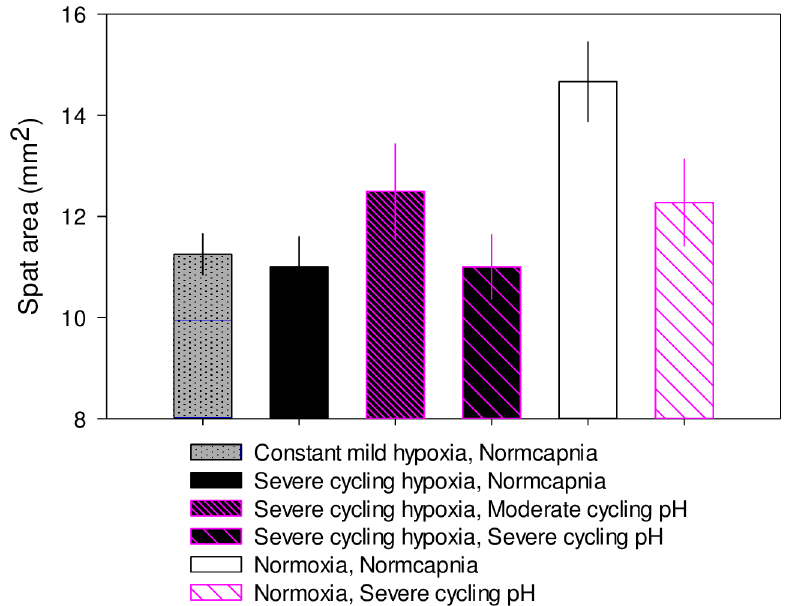
Fig 4. 2014 juvenile growth experiment. Mean ± 1 SE shell area by treatment of juvenile oysters exposed to diel cycles 5 – 6 d wk -1 during a two-week laboratory experiment.